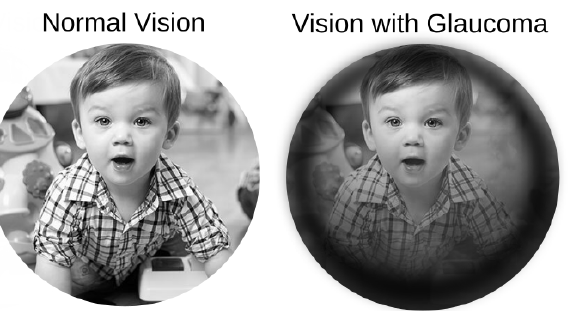
Figure 1. Examples of human vision without ( left side ) and with GON ( right side